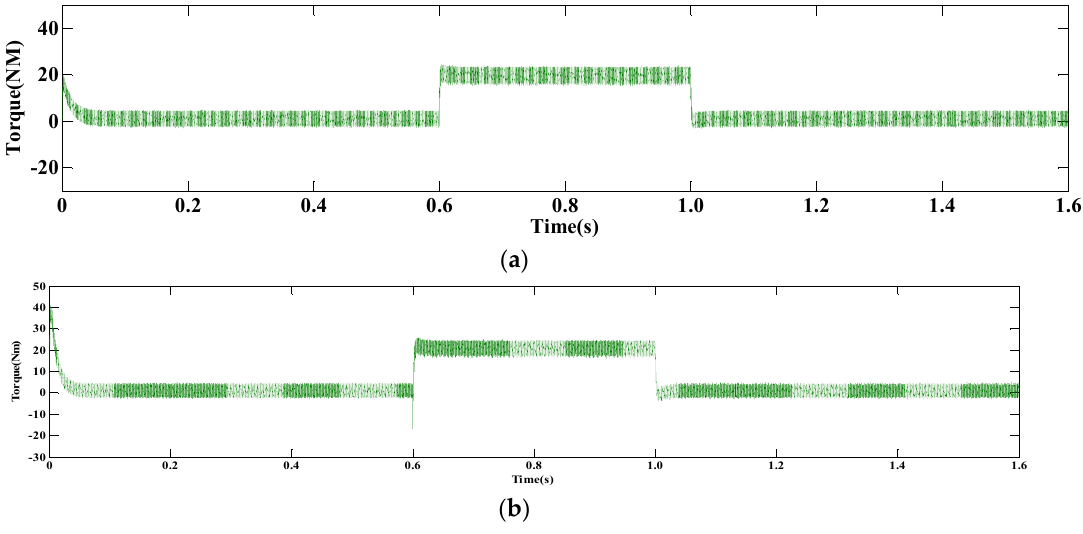
Figure 8. Observation values of torque. ( a ) FTSMC, ( b ) SMC.